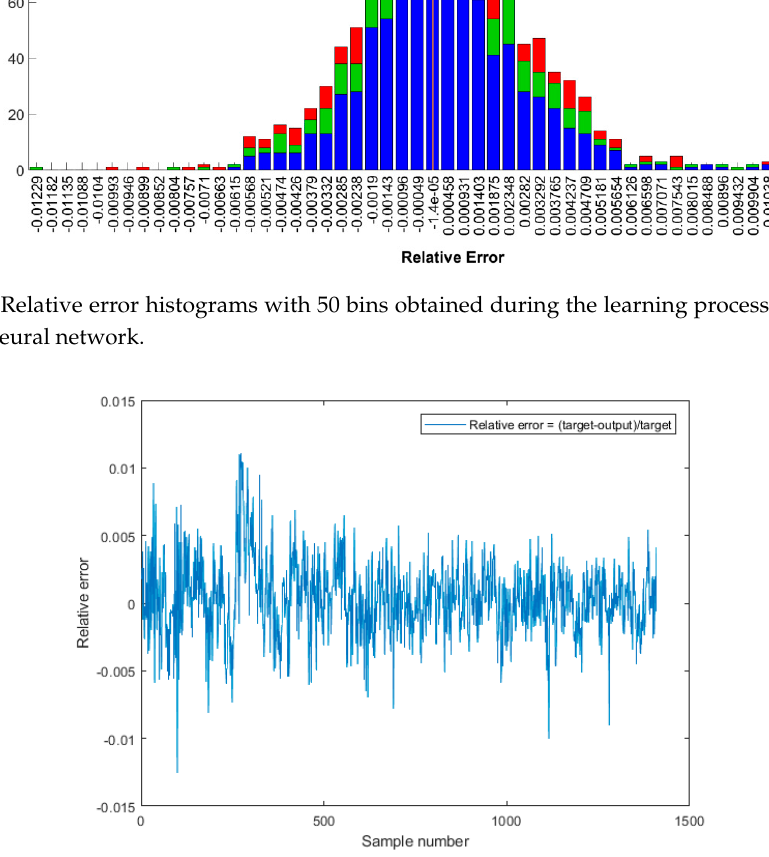
Figure 13. Relative error in accordance to measured sample number obtained during the learning process for the best analyzed neural network.